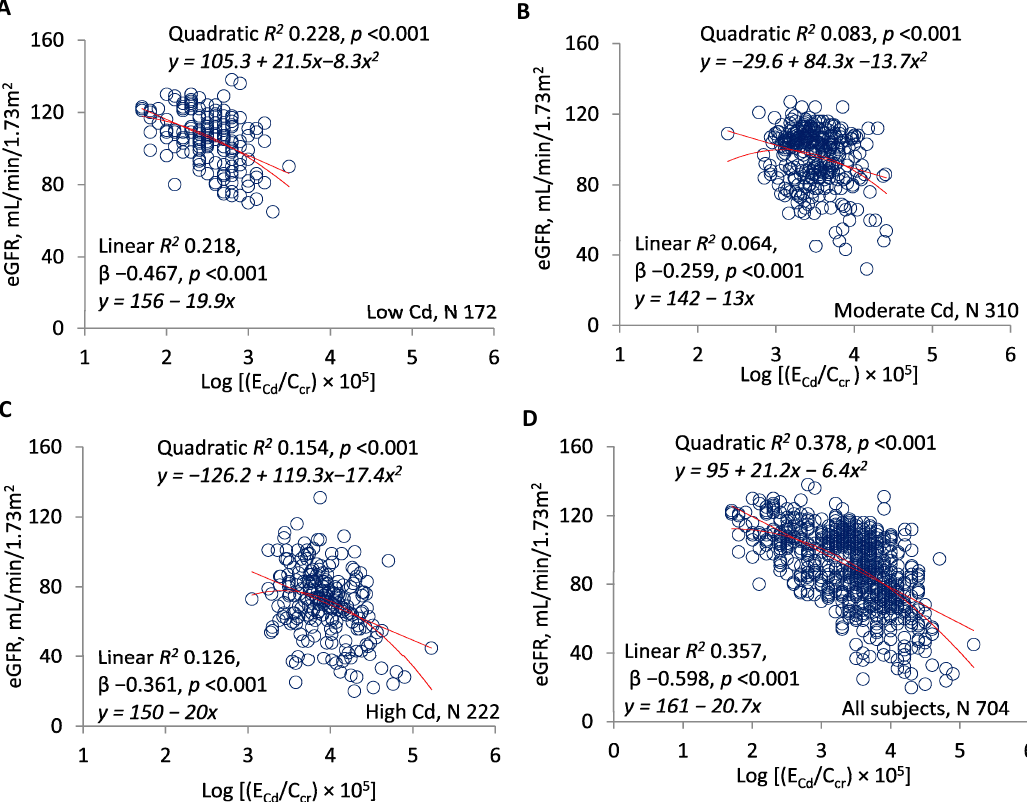
Figure 1. E Cd / C cr as a predictor of the estimated glomerular filtration rate (eGFR). Scatterplots compare eGFR to log[(E Cd / C cr ) × 10 5 ] in subjects grouped by locality ( A – C ) and in all subjects ( D ). Quadratic and linear coefficients of determination ( R 2 ) are provided together with corresponding equations, standardized β coefficients, and p -values.